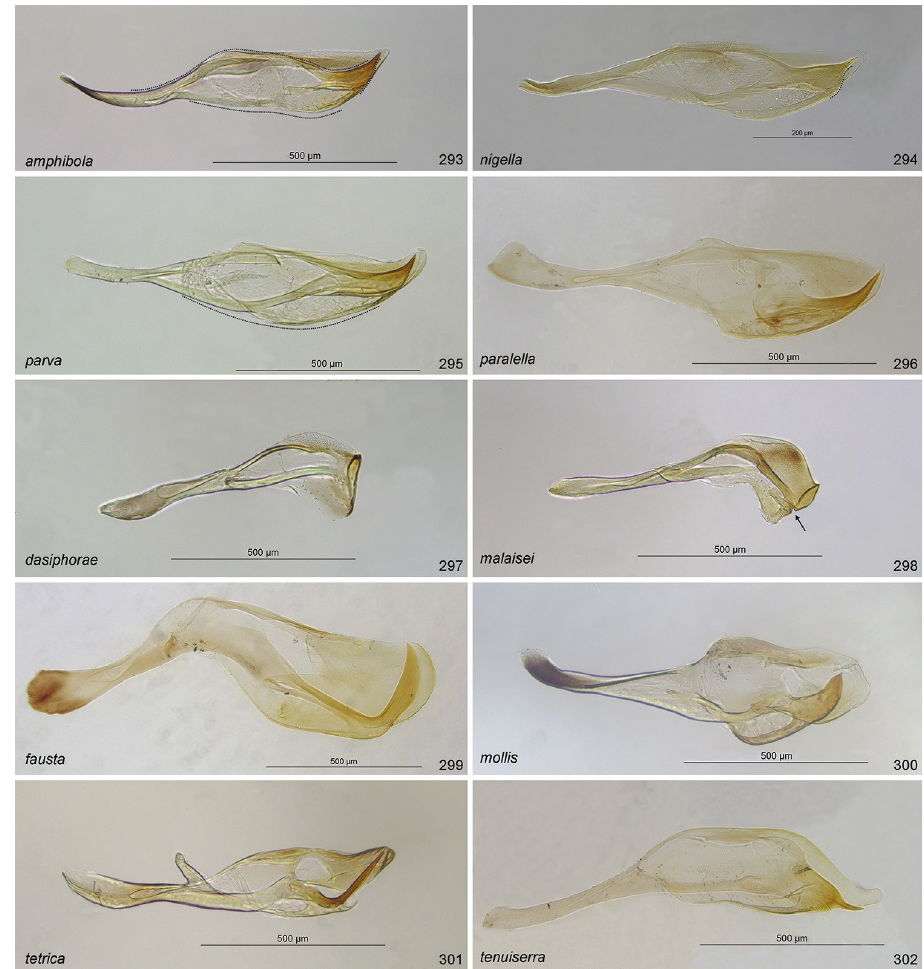
Figures 293–302. Penis valves of Pristiphora . 293 amphibola DEI-GISHym80051 294 nigella PR.523VV 295 parva DEI-GISHym80061 296 paralella 15-269 297 dasiphorae DEI-GISHym20587 298 malaisei DEI-GISHym80112 (arrow indicates a notch) 299 fausta DEI-GISHym31714 300 mollis DEI-GISHym31040 301 tetrica DEI-GISHym20946 302 tenuiserra